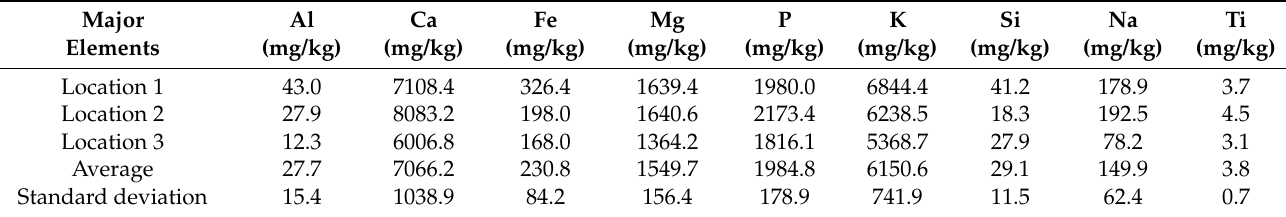
Table 4. Major elements of A. altissima .